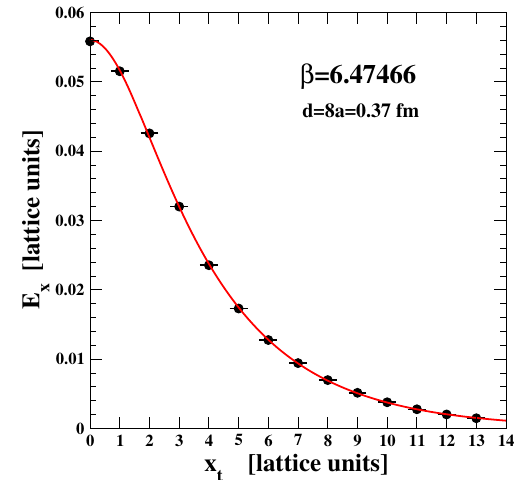
Fig. 8 Clem fit (see Eq. 924) of Ref. [36] to E x in lattice units at β = 6 . 47466 and d = 8 a (cid:9) 0 . 37 fm. The values of E